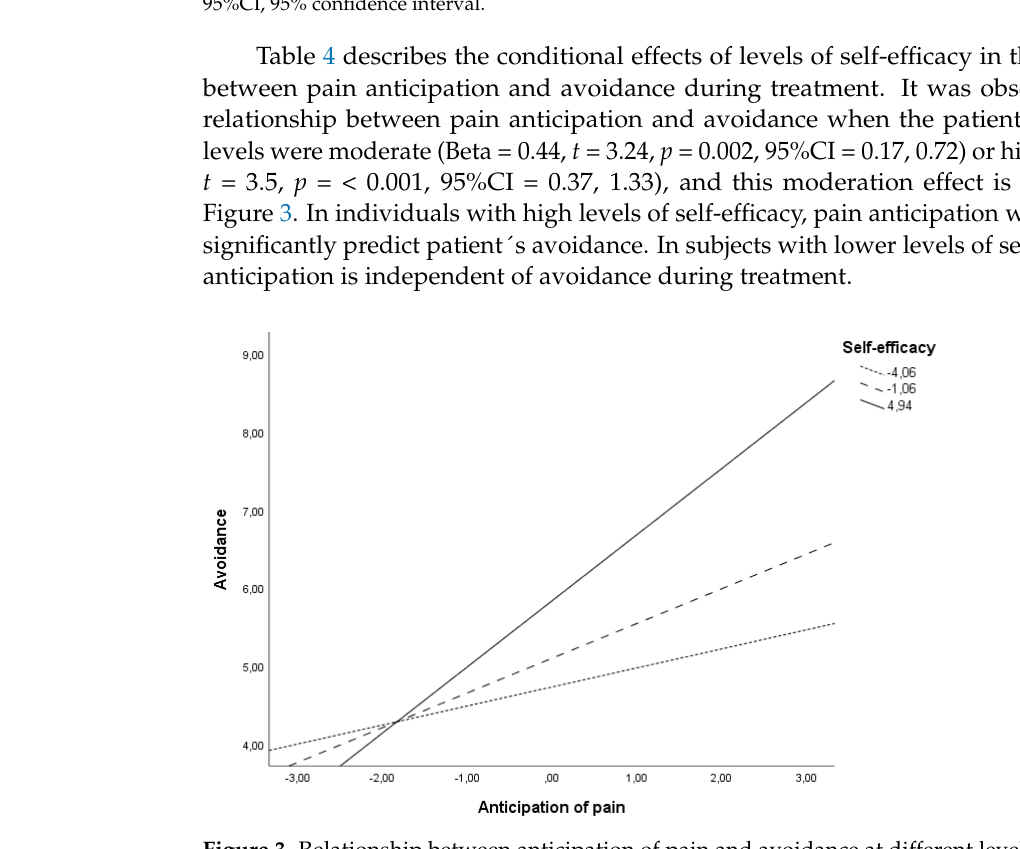
Figure 3. Relationship between anticipation of pain and avoidance at different levels of self-efficacy.